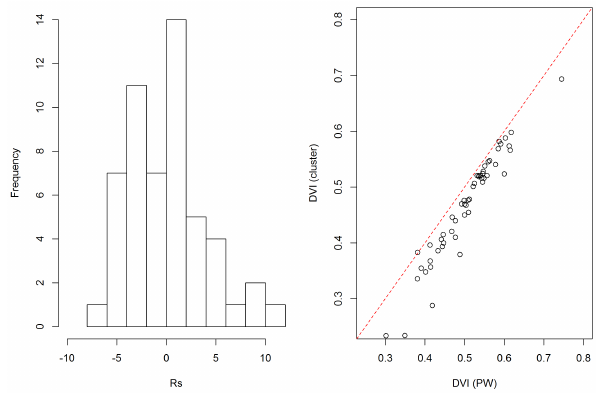
Fig. 5. (a) Difference of country rankings ( R s ) considering the pro- portional weights (PW) compared with equal (EW, in blue) and ran- dom (RW, in pink) weights. (b) Scatterplot of DVI values consider- ing the proportional weights (PW) compared with equal (EW) and random (RW) weights.